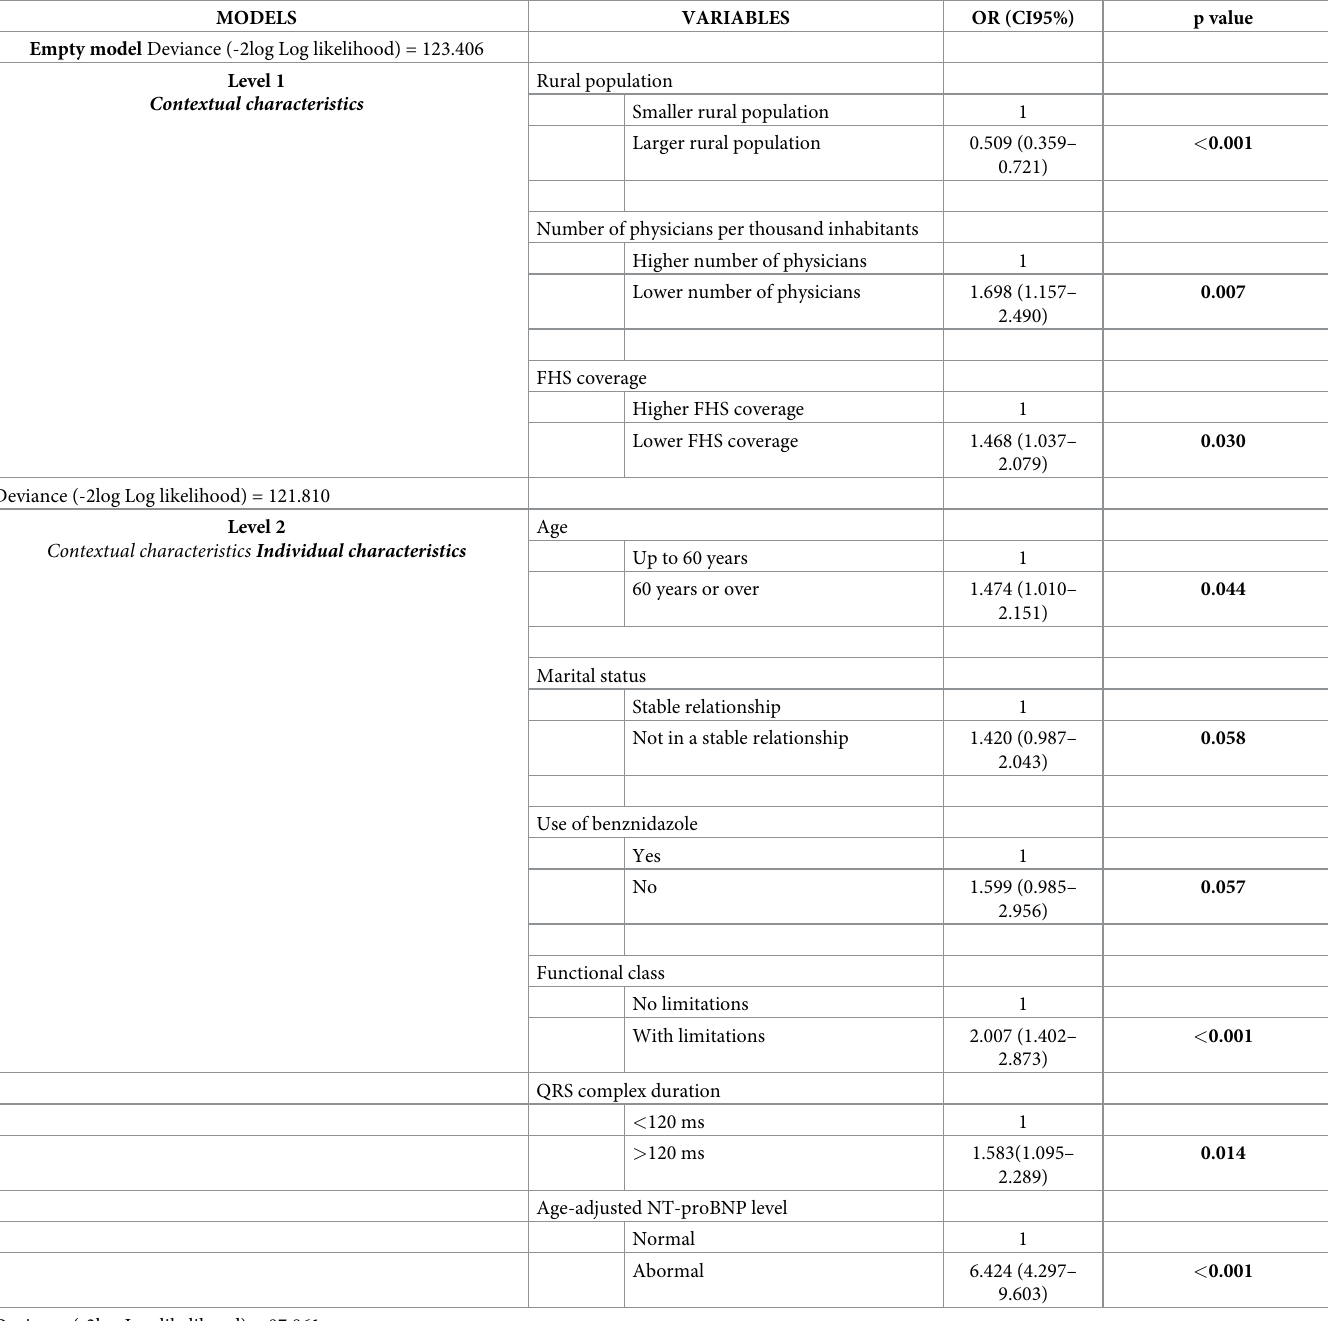
Table 3. Final hierarchical multilevel logistic regression model for the factors associated with the occurrence of cardiovascular events over two years in patients with Chagas disease. Minas Gerais, Brazil (n =